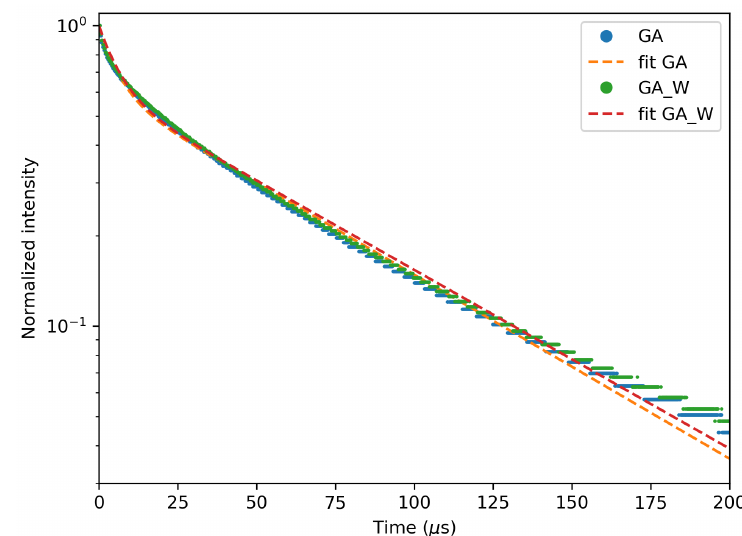
Figure 10. Decay measurement of GA1000 with 2% Nd before and after washing, with their fit.